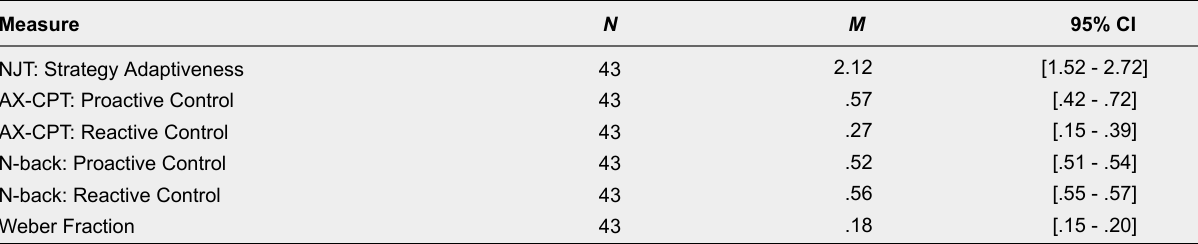
Descriptive Statistics of the Experimental Tasks